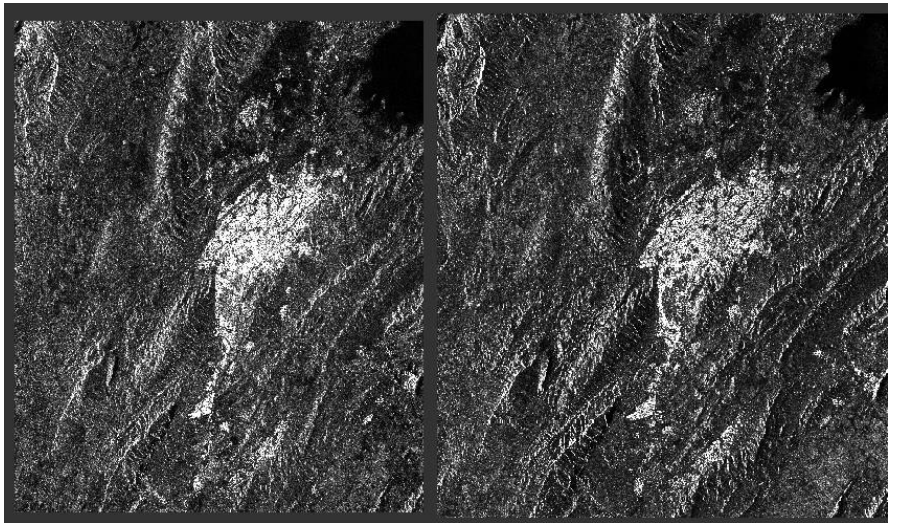
Figure 2. The implemented pre-processing graph of Sentinel- 1A in